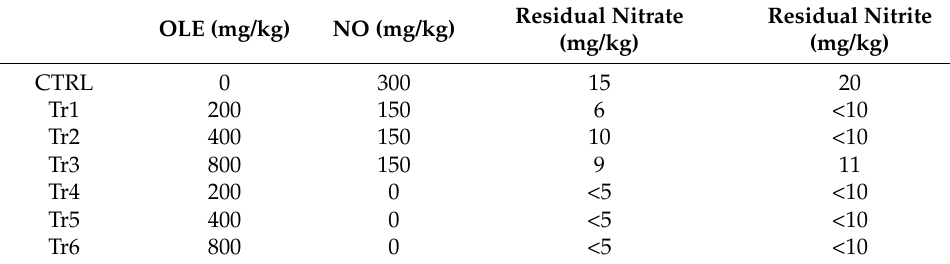
Table 3. Residual nitrate and nitrite content